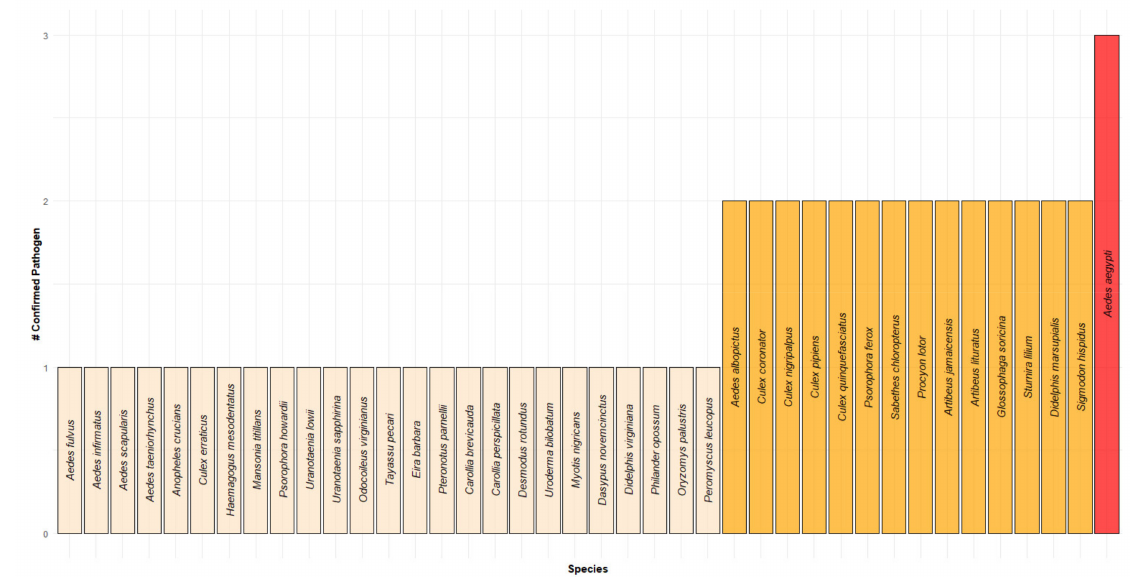
Figure 4. Cohesive block: Common member of the most cohesive blocks of the four pathogens. X-axis: Mosquitoes and mammal species. Y-axis: Number of confirmed pathogens per species.